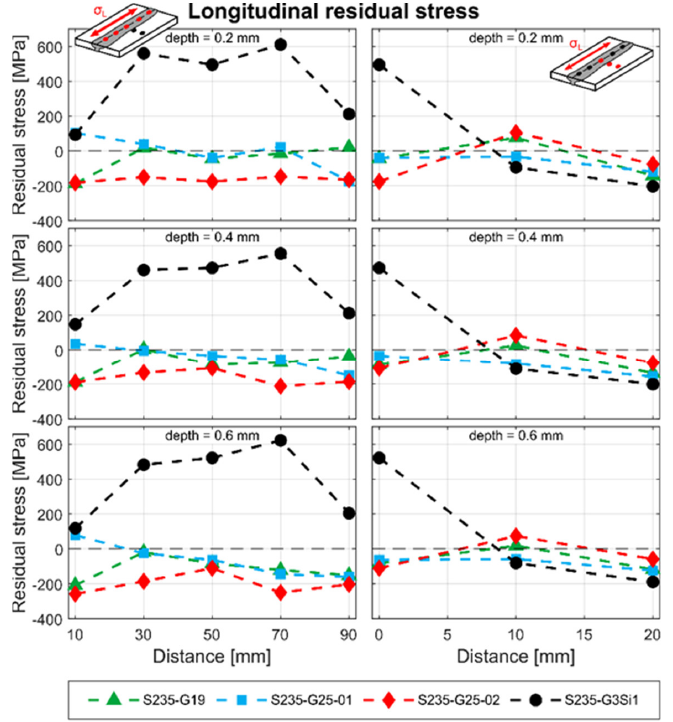
Figure 10. Residual stress measurement using the hole-drilling method and electronic speckle pattern interferometry. Measurements show the longitudinal residual stress along the weld seam (graphs on the left) and in the base material (graphs on the right).